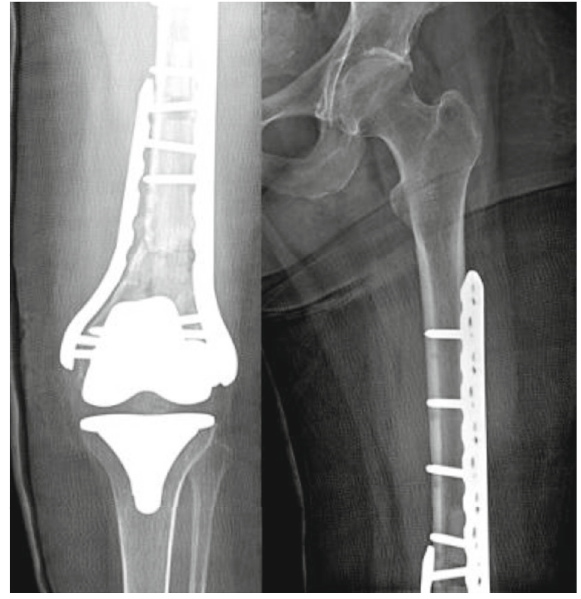
Figure 7: Postoperative follow-up radiographs done one month after revision surgery showing satisfactory